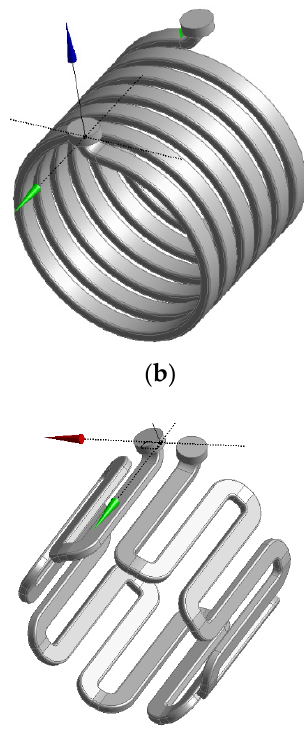
Figure 14. 24 s/28 p liquid-cooled configuration with flux barriers used as channels [93]. The flux barriers can be used on their own or as an extension of a water jacket.